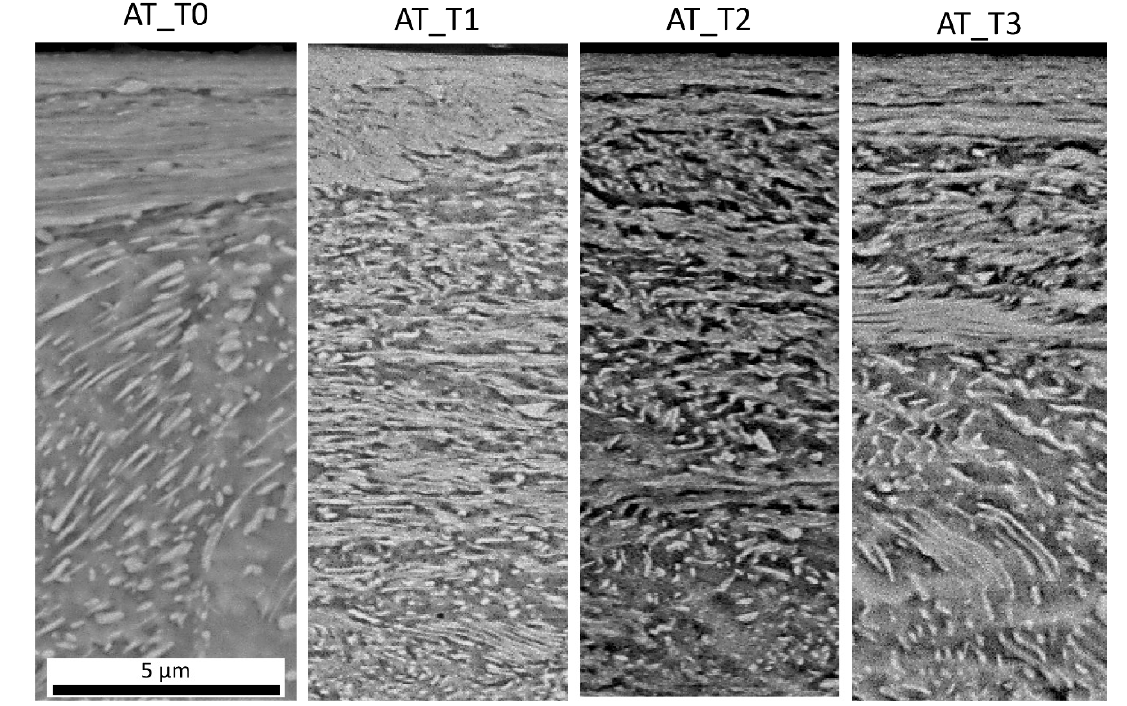
Figure 7. SEM images of the near-surface in the transverse direction, for all the tracks of Ring AT.